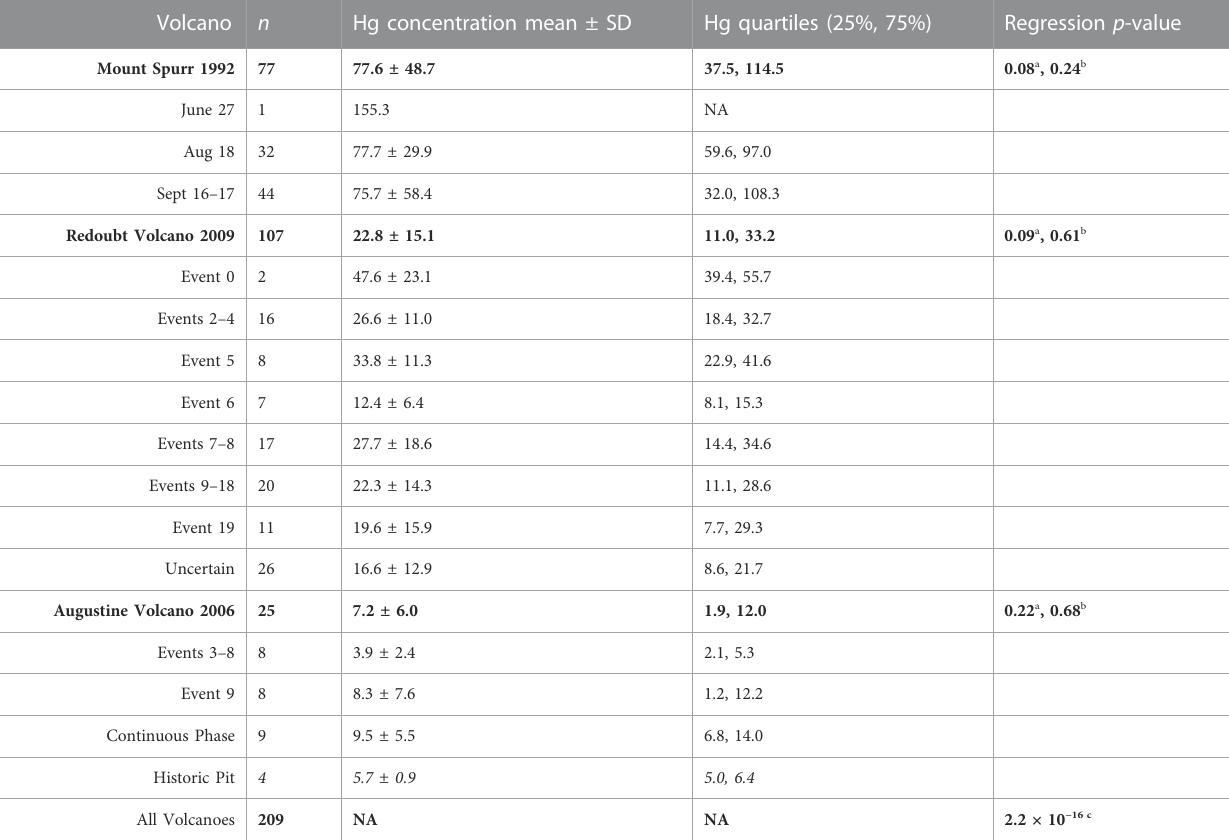
TABLE 1 Descriptive statistics of analyzed Mount Spurr, Redoubt Volcano, and Augustine Volcano ash. Descriptive statistics for the full volcanic sample set are in bold and broken into individual events beneath. Concentration data are presented as ng g − 1 .